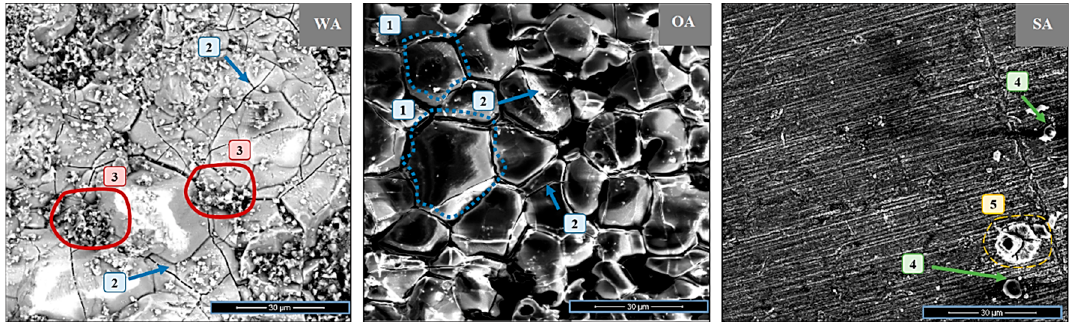
Figure 1. SEM images of an Inconel 625 surface after corrosion tests with mixed wood ash (WA), oat straw ash (OA), and sewage sludge ash (SA).